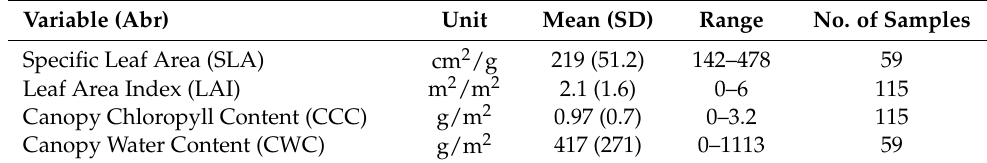
Table 2. Overview statistics of measured and targeted variables of Grosseto and MNI